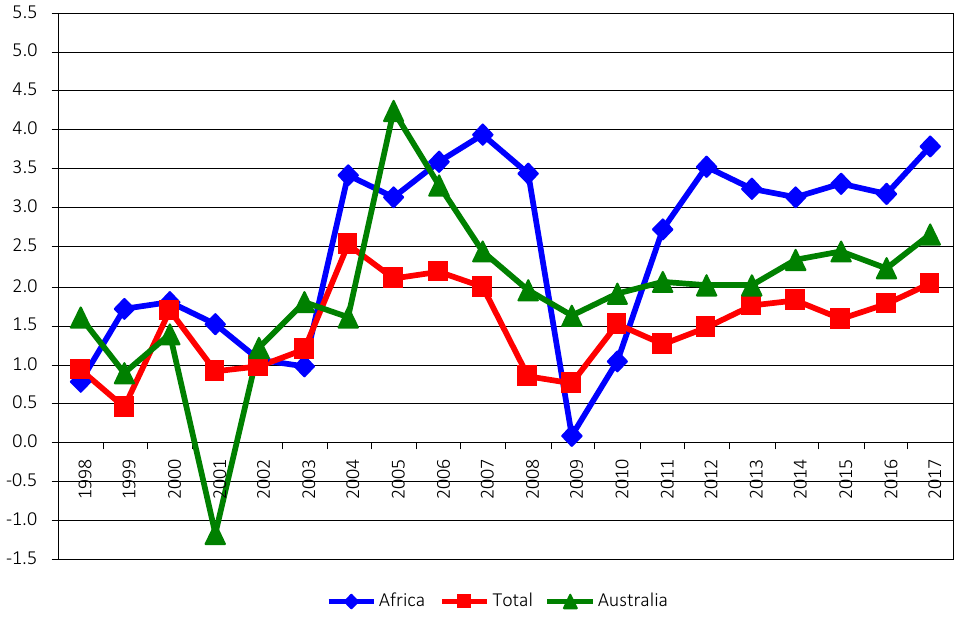
-1.0-0.50.00.51.01.5 Figure 4. Financial stability index of the banking systems of the World, the EU, and Europe